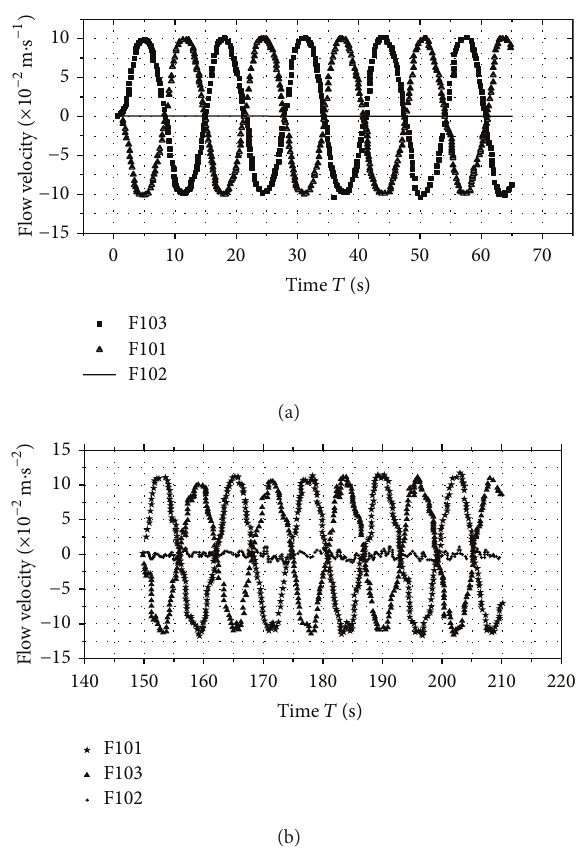
Figure 3: Comparison of experimental results and calculated results of rolling motion with swing angle 𝜓 𝑚 = 22.5 ∘ and rolling cycle 𝑇 = 13 s in zero-power condition: (a) calculated result; (b) experimental